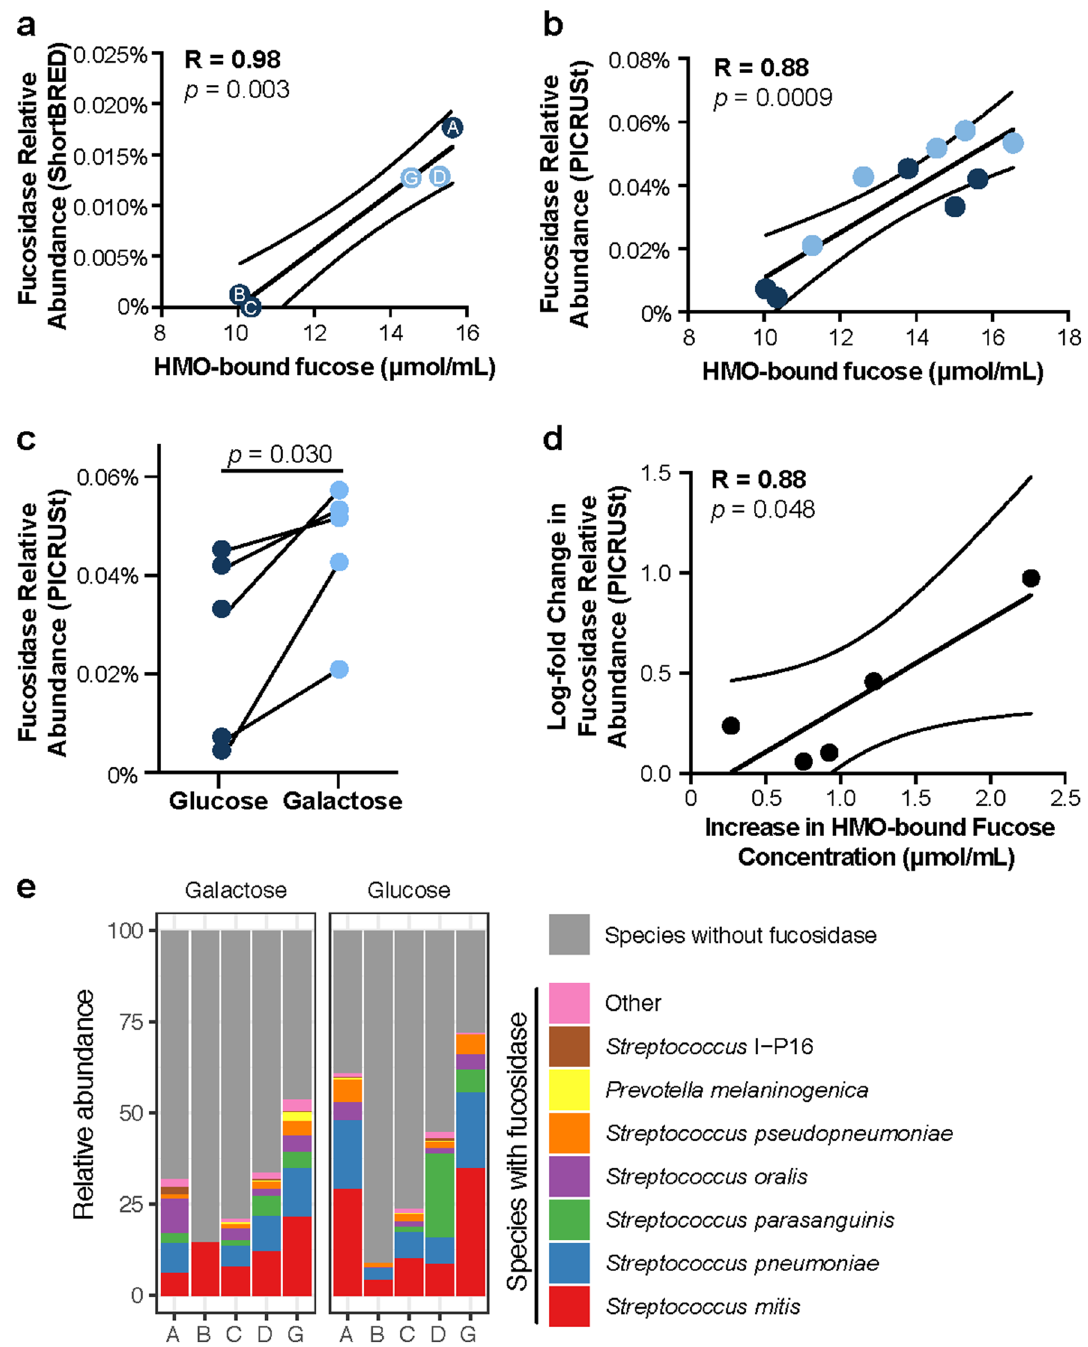
Figure 5. Levels of HMO-bound fucose are specifically and significantly associated with bacterial fucosidase abundance in the milk microbiome. ( a) Linear regression reveals tight association between HMO-bound fucose concentration and bacterial fucosidase (K01206) abundance as determined by ShortBRED in Glu/Gal Cohort (R = 0.98, p = 0.003, linear regression). As not all samples had sufficient sequence coverage for ShortBRED analysis, samples included are indicated by letters (subject ID) and colors (light blue: galactose diet, dark blue: glucose diet). ( b) Linear regression of HMO-bound fucose and bacterial fucosidase abundance determined by PICRUSt for all samples in Glu/Gal Cohort (R = 0.88, p = 0.0009, linear regression) confirms tight association between levels of HMO-bound fucose and fucosidase abundance. ( c) Bacterial fucosidase abundance (PICRUSt) increases with galactose relative to glucose diet ( p = 0.030, paired t-test), which is concordant with the increase in HMO-bound fucose with galactose relative to glucose diet (Fig. 2). ( d) The magnitude of the increase in bacterial fucosidase abundance (PICRUSt) with diet is proportionate to the increase in HMO-bound fucose (R = 0.88, p = 0.048, linear regression), suggesting that the increase in HMO-bound fucose may drive a proportionate increase in bacteria with fucosidase genes. ( e) Relative abundance of likely non-contaminant bacterial species with fucosidase (as annotated in UniProt) in each sample of the Glu/Gal Cohort as determined by WGS sequencing reveals the majority of fucosidase-possessing taxa are Streptococcus spp. Error bars in linear regression analyses indicate 95% confidence